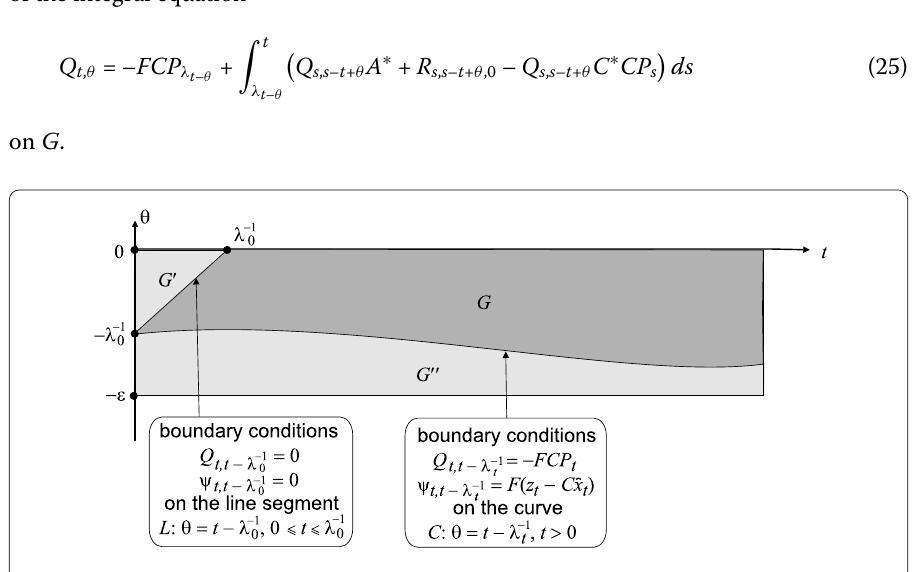
Figure 3 The regions G , G (cid:2) , and G